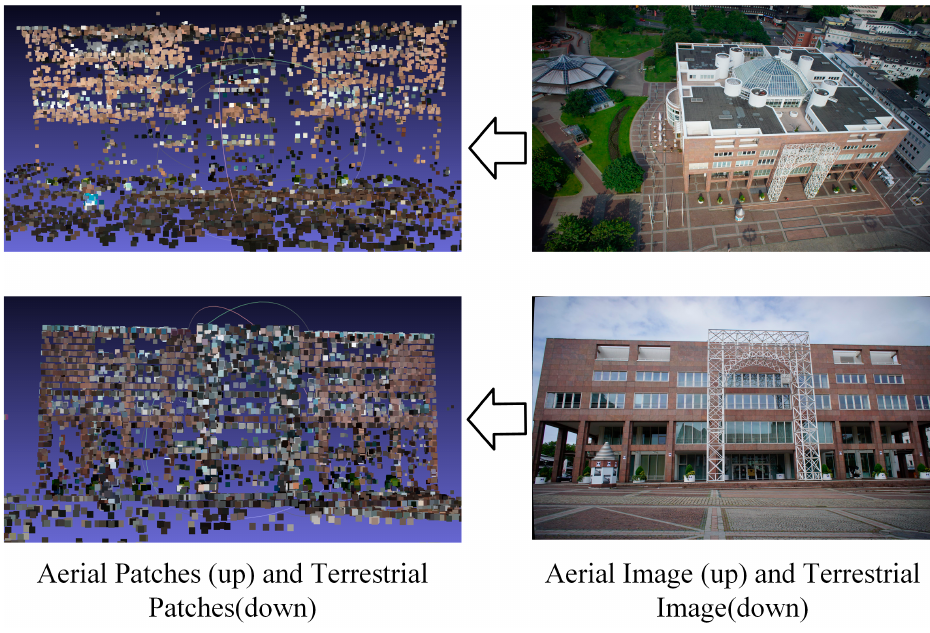
Figure 9. Results of variational patch refinement.